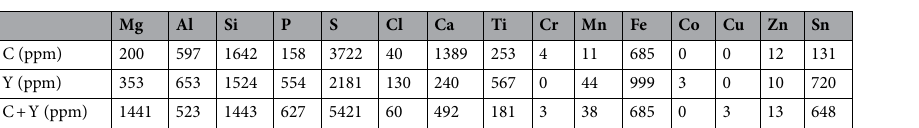
Table 7. Average composition of elements in cassava peels, yam peels, and cassava + yam mix. C—Cassava peels biomass. Y—Yam peels biomass. C + Y—Cassava + yam peels